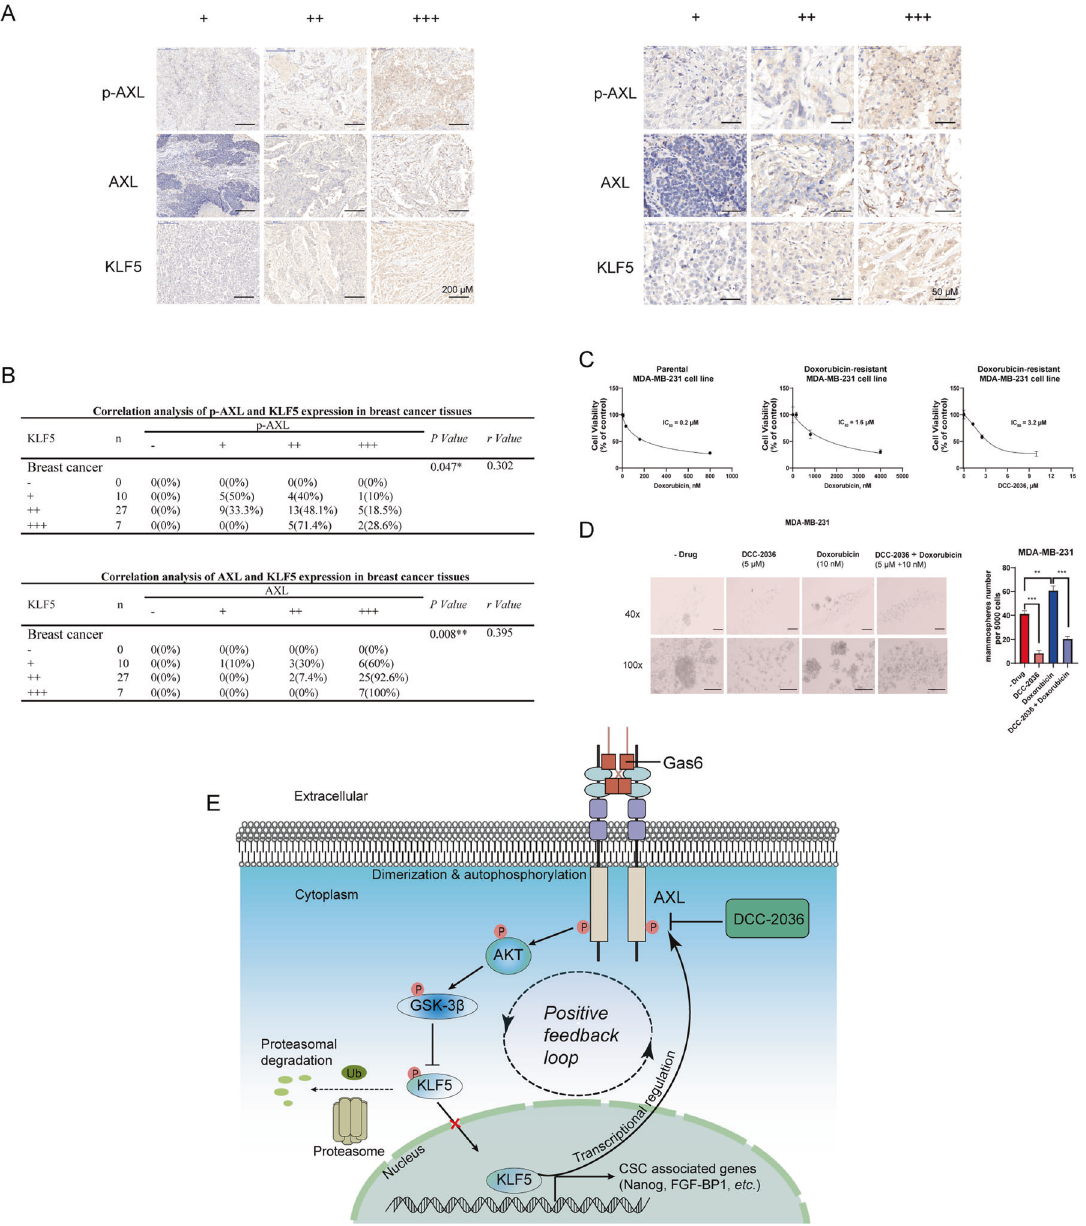
Fig. 8 The expression of p-AXL and AXL positively correlates with the expression of KLF5 in human TNBC specimens. Moreover, DCC- 2036 increases the sensitivity of TNBC chemotherapy by decreasing BCSCs. A Representative immunohistochemical staining images of p- AXL, AXL, and KLF5 protein in TNBC specimens, in which the expression of p-AXL, AXL, and KLF5 proteins was indicated by mild positive ( + ), moderate positive ( ++ ), and strong positive ( +++ ), respectively. Left: Scale bars, 200 μ m (magni fi cation 40×); Right: Scale bars, 50 μ m (magni fi cation 100×). B The expression levels of p-AXL, AXL, and KLF5 in TNBC samples were positively correlated. The statistical signi fi cance was determined by Spearman correlation analysis. R-value is the correlation coef fi cient. * P < 0.05, ** P < 0.01. C The cell viability analysis of MDA-MB-231 and the doxorubicin-resistant MDA-MB-231 cells after treating with different concentrations of doxorubicin and DCC-2036 ( n = 3). D The number and size of mammospheres formed following treatment with doxorubicin (10 nM), DCC-2036 (5 μ M), and a combination of doxorubicin and DCC-2036 in MDA-MB-231 cells. Scale bars, 100 μ m (magni fi cation 40×); Scale bars, 100 μ m (magni fi cation 100×). The histogram represents the mean value of three experiments. The statistical signi fi cance was determined by Student ’ s t -test. ** P < 0.01, *** P < 0.001. E Schematic representations of the inhibitory effect of DCC-2036 on triple-negative breast cancer stem cells through AXL-KLF5 positive feedback loop. In the progression of TNBC, AXL can activate Akt, which subsequently increases GSK3 β (S9) phosphorylation and leads to the GSK3 β inactivation. However, GSK3 β -mediated KLF5 (S303) phosphorylation level promotes the KLF5 ubiquitination by SCF Fbw7E3 ubiquitin ligase and degradation by 26 S proteasome. Thus, KLF5 into the nucleus promotes the expressions of stemness-associated transcription factors, and in turn, KLF5 binds to the AXL promoter region ( − 171 to − 162 bp), which forms a positive feedback regulation mechanism further to facilitate tumorigenesis. DCC-2036 inhibits the expression of KLF5 via the AXL-Akt-GSK3 β signal axis and further disrupts the AXL-KLF5 positive feedback loop. Ultimately, DCC-2036 inhibits TNBC stem cells and suppresses TNBC development.